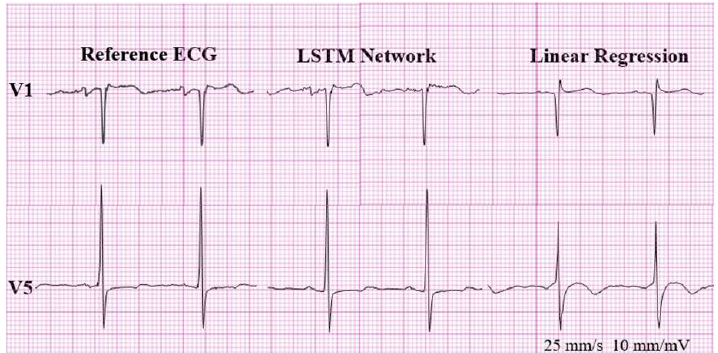
Figure 8. False negative result for LVH.